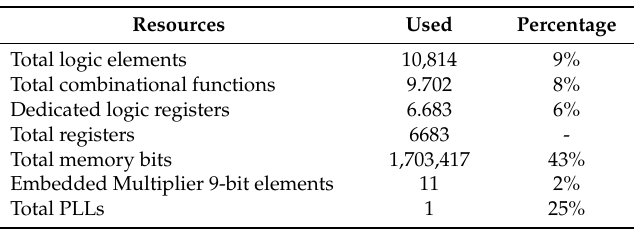
Table 5. Hardware resources utilization.